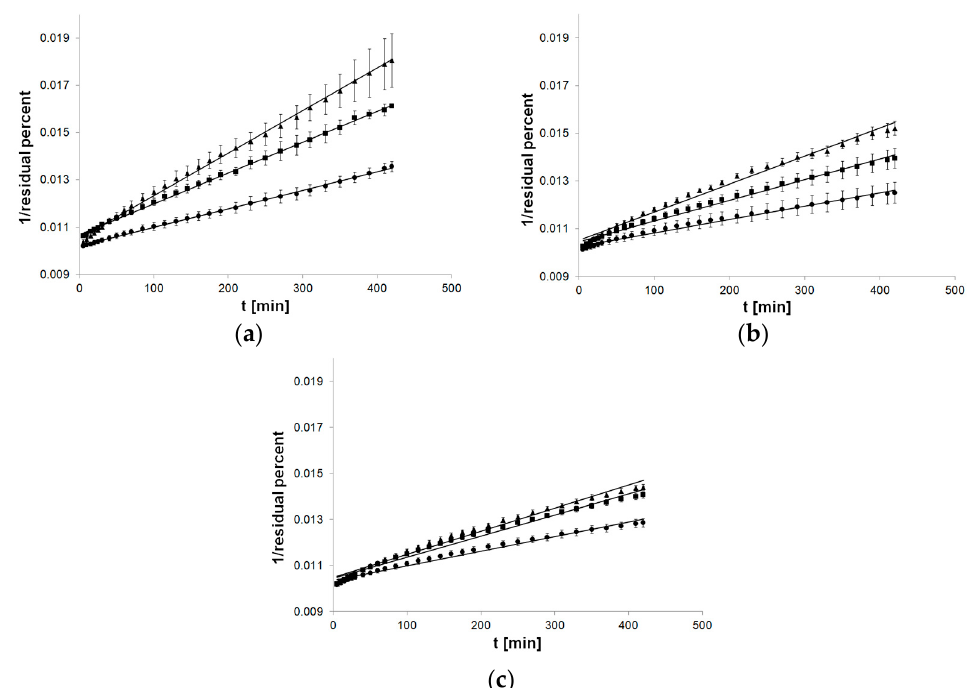
Figure 4. Process of release kinetics of β E performance according to second-order kinetics model; ( a ) MC gel formulations, ( b ) PA1 gel formulations, ( c ) gel formulations with PC-11; ▲ —reference gel, ■ —20% of MSA, ● —40% of MSA, n = 6.